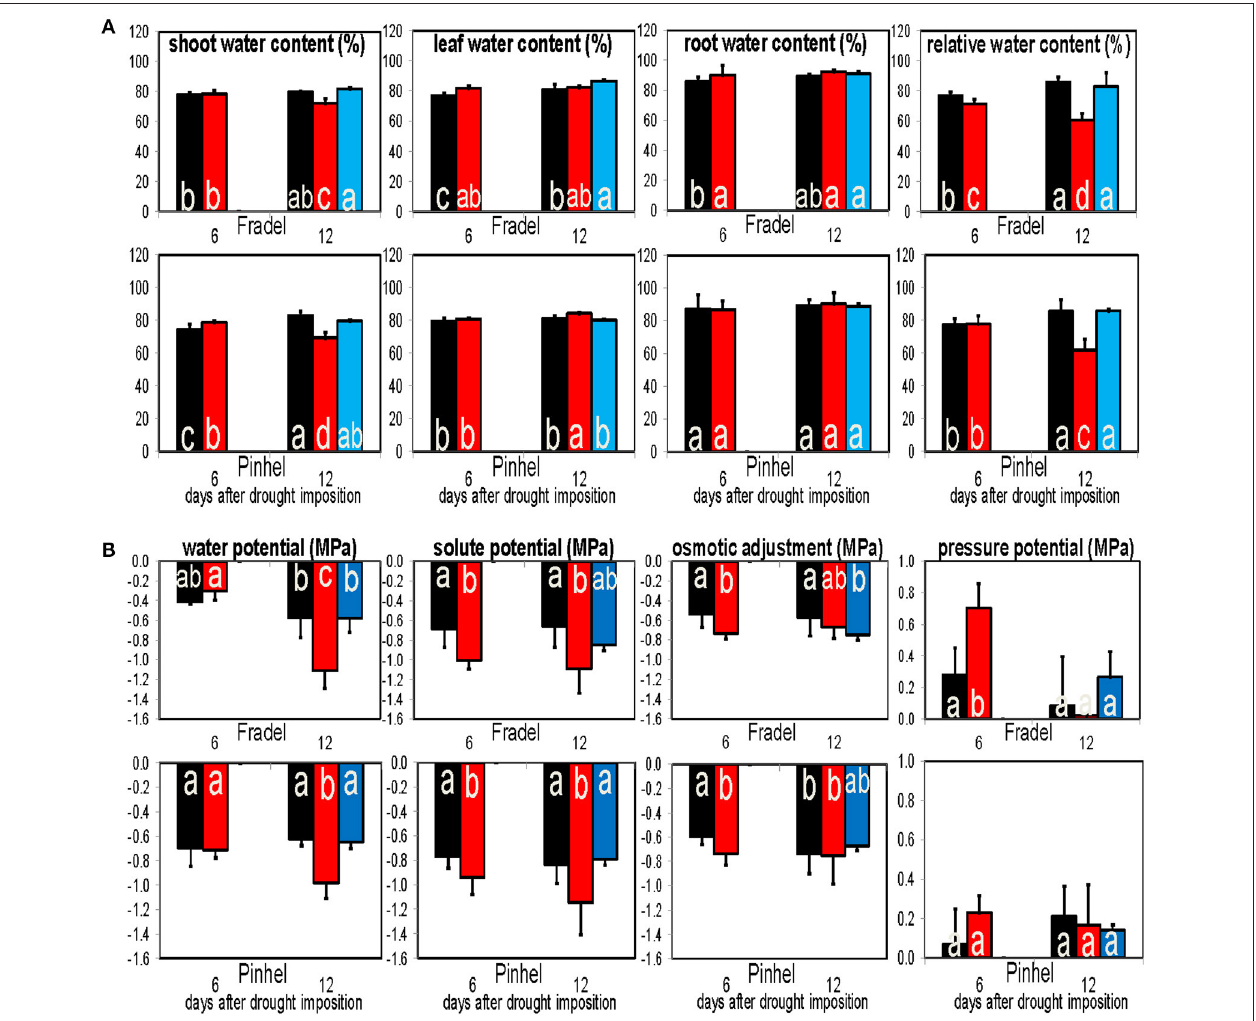
FIGURE 14 | Responses of water content (A) and water potential components (B) to drought stress and rewatering. Pressure potential, water potential—solute potential; Osmotic adjustment, osmotic potential values corrected to full turgor by multiplying with relative water contents. Bars indicate the well-watered controls (black), plants drought-stressed for 6 or 12 days (red), and rewatered plants after 6 days of drought stress (blue; n = 6; error bars = SD). Different letters inside the columns for each cultivar denote statistical differences (Tukey’s test; P <